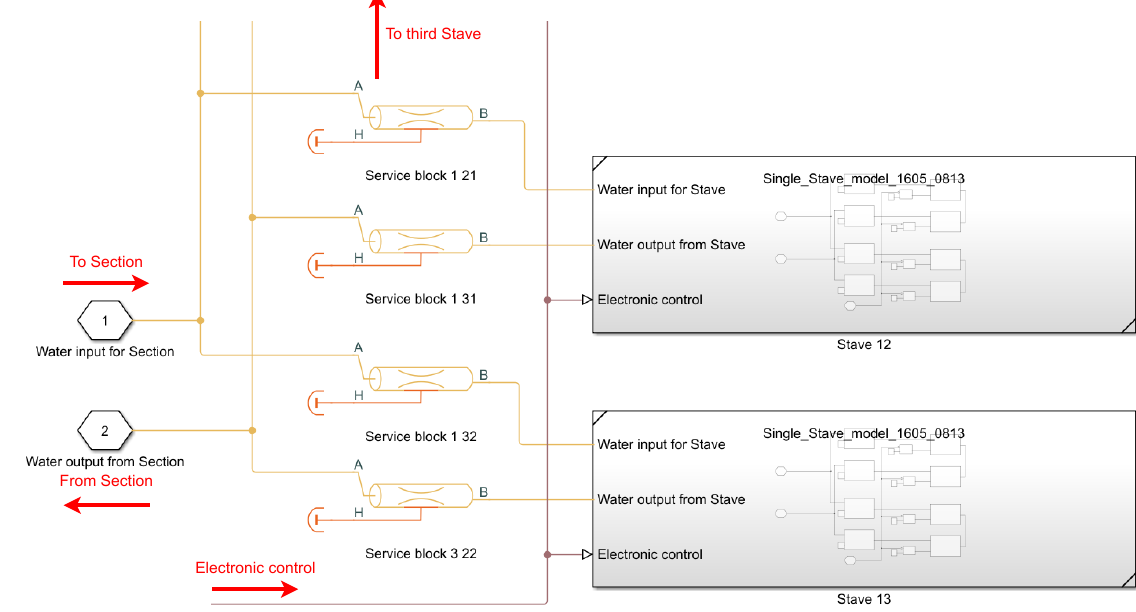
Figure 14. The section internal structure